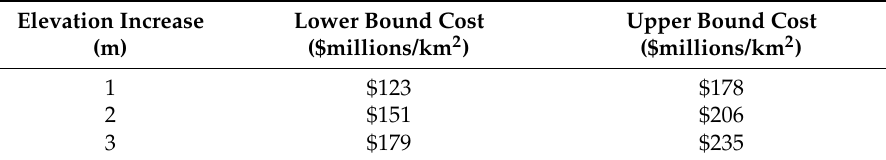
Table 8. Total cost in millions of US dollars per square kilometer of port area to increase port elevation one to three meters and retrofit port.